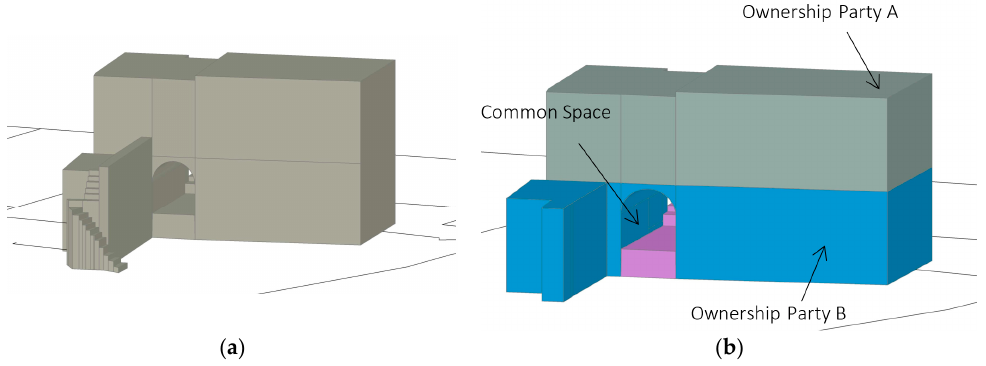
Figure 13. ( a ) The physical model of the building (IFC); ( b ) The legal model of the building.